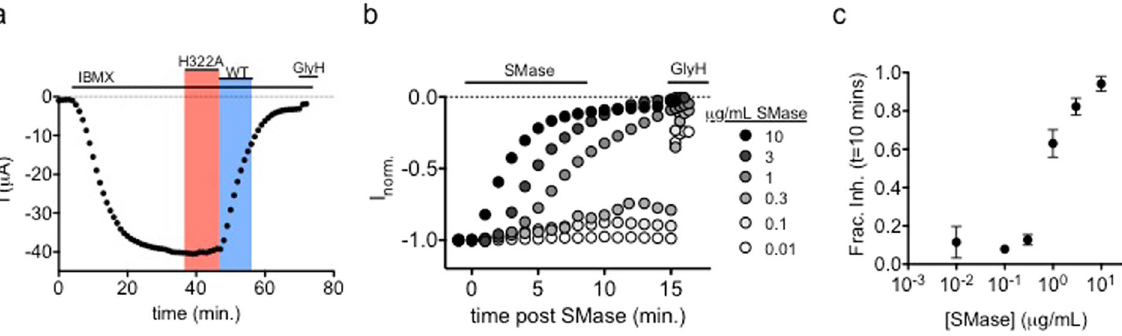
Figure 1. Inhibition results from enzymatic activity of SMase: ( a ) WT-human-CFTR currents elicited with 0.1 mM IBMX and a voltage step to − 60 mV were inhibited by 2 μ g/mL WT SMase but not by the inactive H322A mutant (n = 6). ( b ) Example traces show that inhibition rate was proportional to SMase concentration. For display, currents were normalized to the amplitude 1 minute prior to application of enzyme. SMase was applied from 0–10 minutes. Sensitivity to GlyH-101 applied at the end of the experiment shows that remaining currents represented uninhibited CFTR channels. ( c ) Summary data showing that fractional inhibition at 10 minutes was proportional to SMase concentration (n =